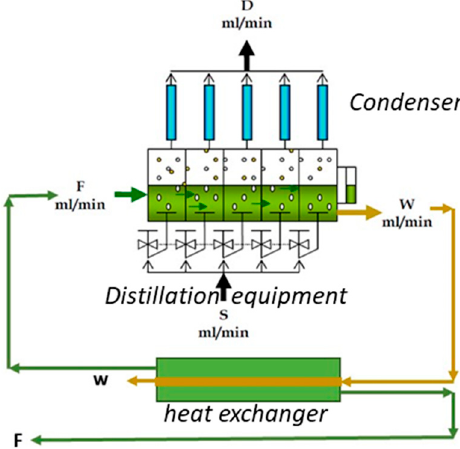
Figure 2. Schematic diagram of continuous distillation.